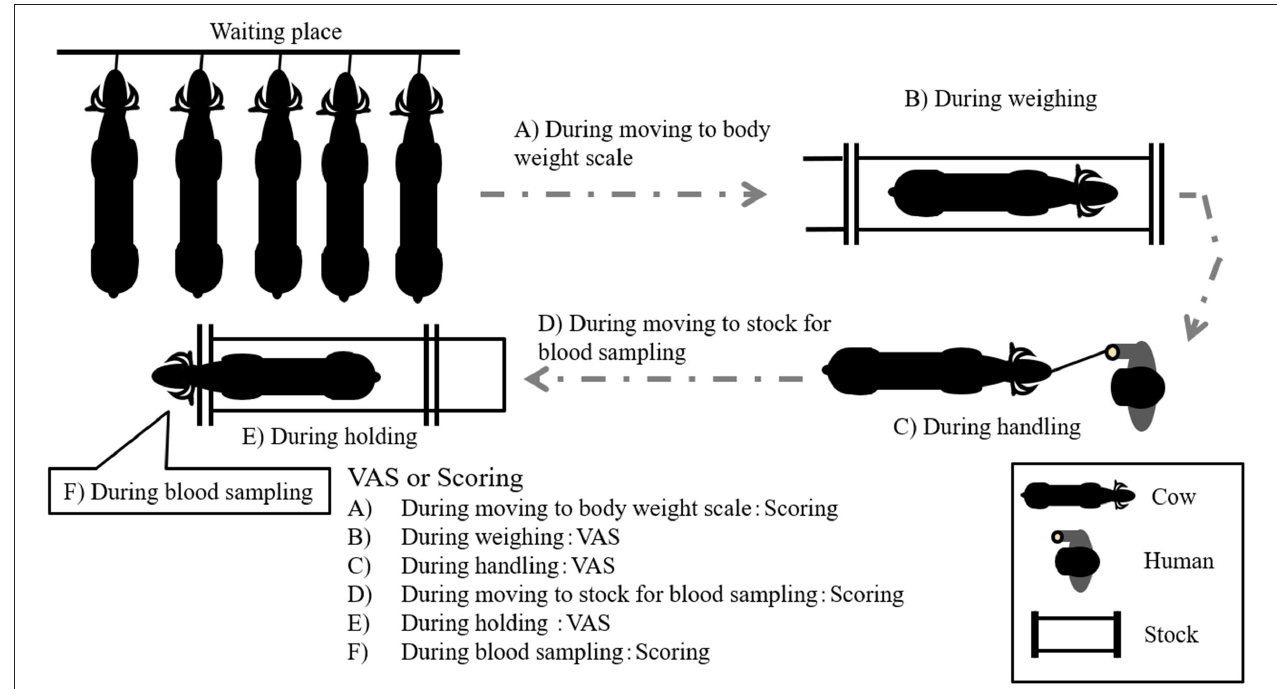
FIGURE 1 | Outline of the evaluation of